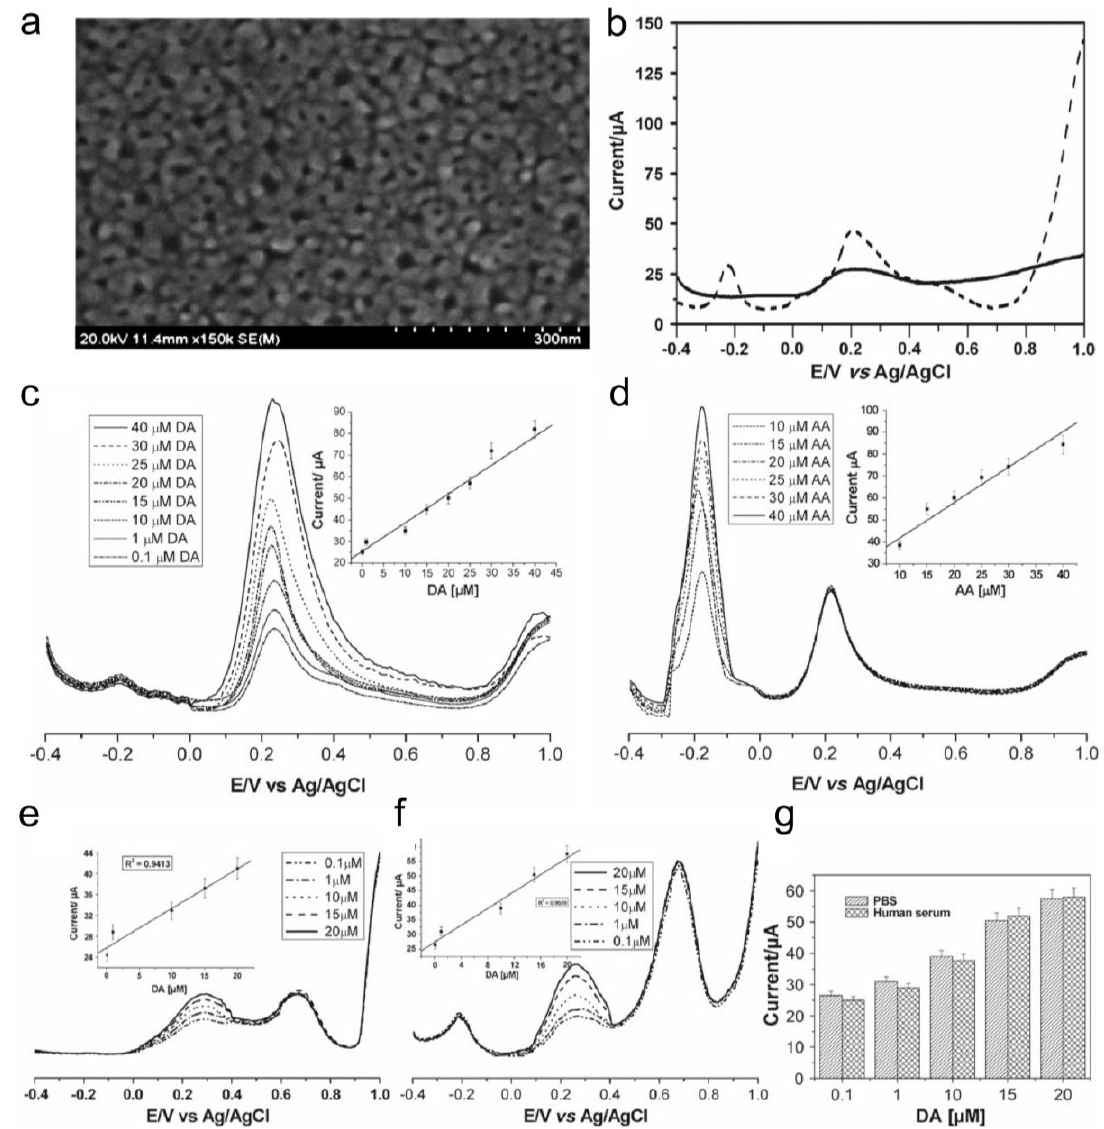
Figure 1. ( a ) Scanning Electron Microscopy (SEM) image of a nanoporous gold film (NPGF)-based electrode surface. Differential pulse voltammetry (DPV) results for ( b ) a mixture of ascorbic acid (AA) and dopamine (DA) at (solid line) bare Au and (dashed line) NPGF electrode; ( c ) Varying concentrations of DA (0.1–40 μM) in the presence of AA (5 μM). Inset: Linear plot of the anodic current peak as a function of the DA concentration ( d ) varying concentrations of AA (10–40 μM) in the presence of DA (5 μM). Inset: Linear plot of anodic current peak as a function of AA concentration; ( e ) Varying concentrations of DA in the presence of uric acid (UA) (500 μM). Inset: Linear plot of anodic current peak as a function of DA concentration; ( f ) Varying concentrations of DA in the presence of AA (5 μM) and UA (1 mM). Inset: Linear plot of anodic current peak as a function of DA concentration; ( g ) Anodic current peak corresponding to oxidation of varying concentrations of DA (0.1–20 μM) in the presence of AA (5 μM) and UA (0.5 mM) in both human serum and phosphate buffered saline (PBS) buffer. (Modified from Ref. [29] with permission, Copyright 2010 Elsevier (Amsterdam, The Netherlands)).